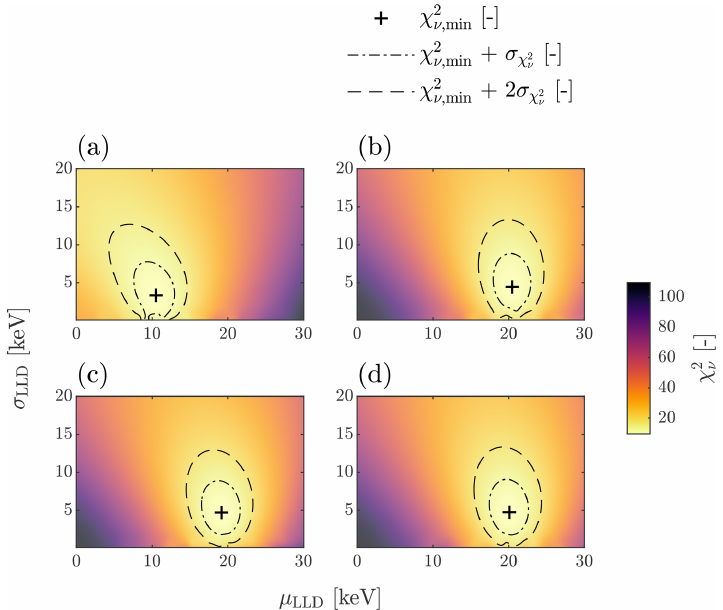
Figure B1. χ 2 ν contour maps for the four individual scintillation crystals 1–4 (a–d) as a function of the lower level discriminator model parameters µ LLD and σ LLD . The global minima ( χ 2 ) are marked with a plus sign together with the corresponding 1 and 2- σ confidence ν, min regions indicated by the dashed-dotted and dashed contour lines, respectively.